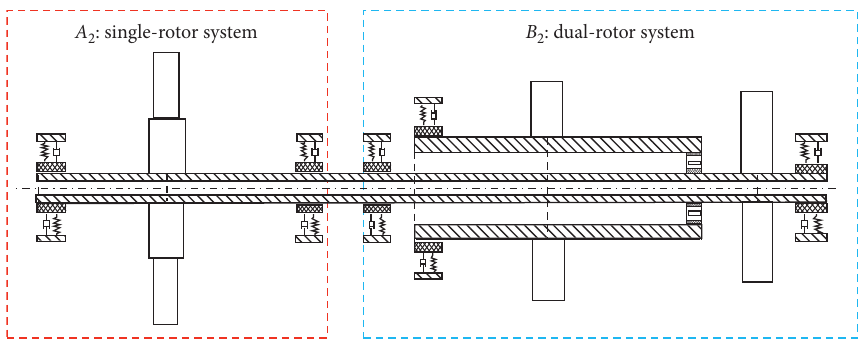
Figure 12: A further simplified dynamic model of the dual-rotor system for an aeroengine.